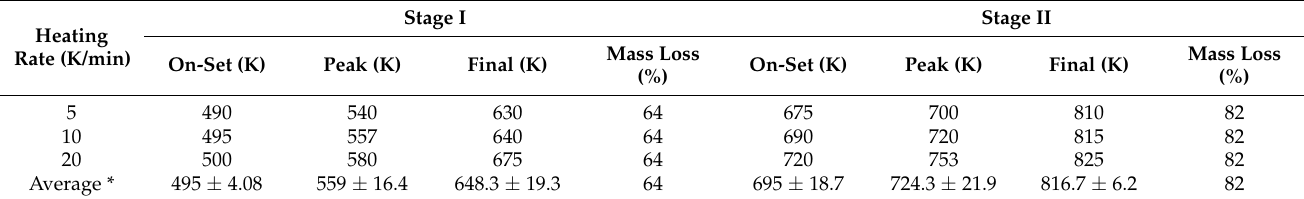
were observed at temperatures of 599 ± 16.4 K. and 724.3 ± 21.9 K, respectively. Table 4. Characteristic temperatures of the PVC pyrolysis at different heating